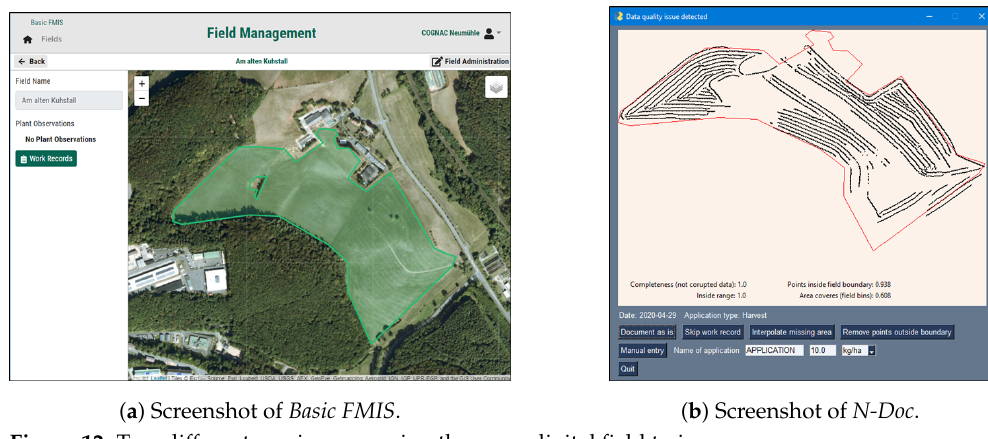
Figure 12. Two different services accessing the same digital field twin.